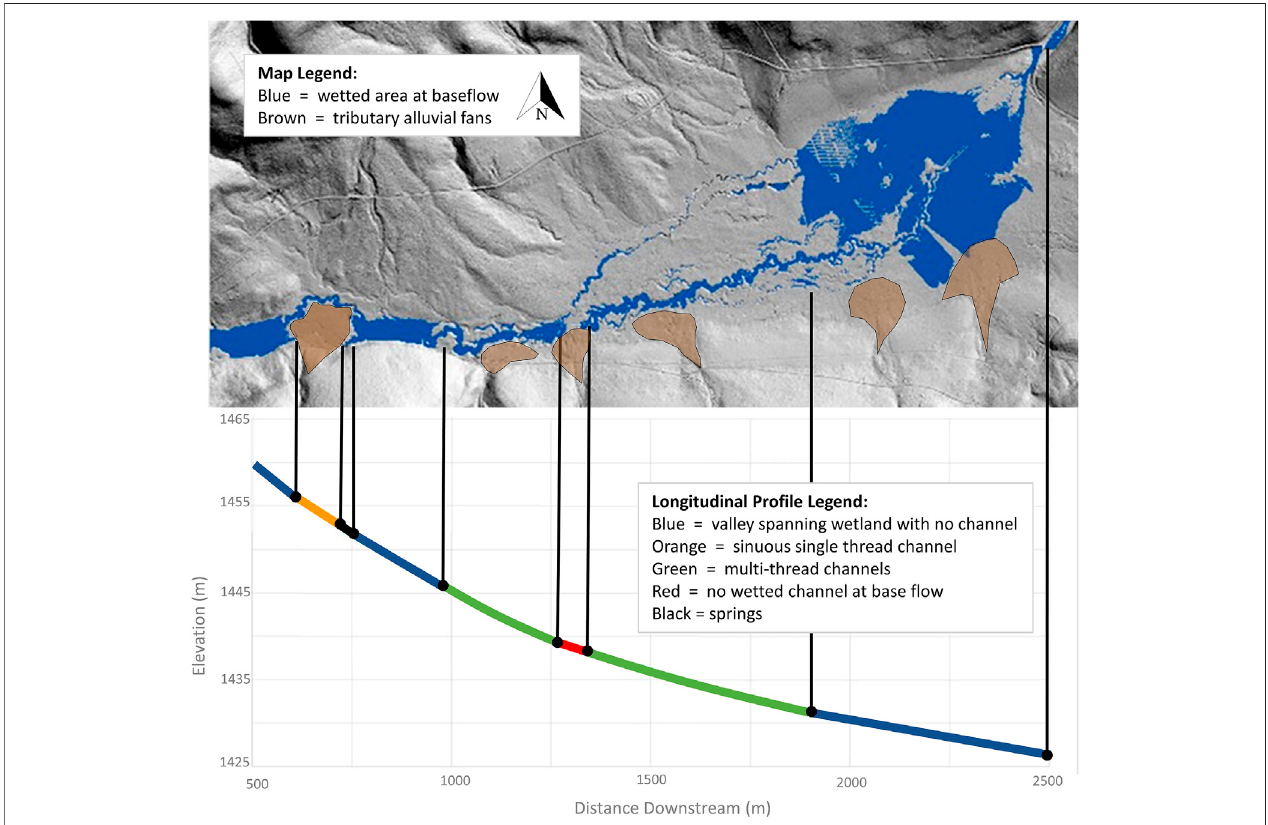
FIGURE 5 | Example of variability in channel planform and partitioning of water between channels, wetlands, and the shallow aquifer within a single, contiguous river-wetland corridor. Large tributary fans on the northern boundary are easily discernible, while smaller fans on the southern boundary have been highlighted to show their in fl uence on fl uvial processes within this continuous valley. North Fork Crooked River, Oregon, United States.